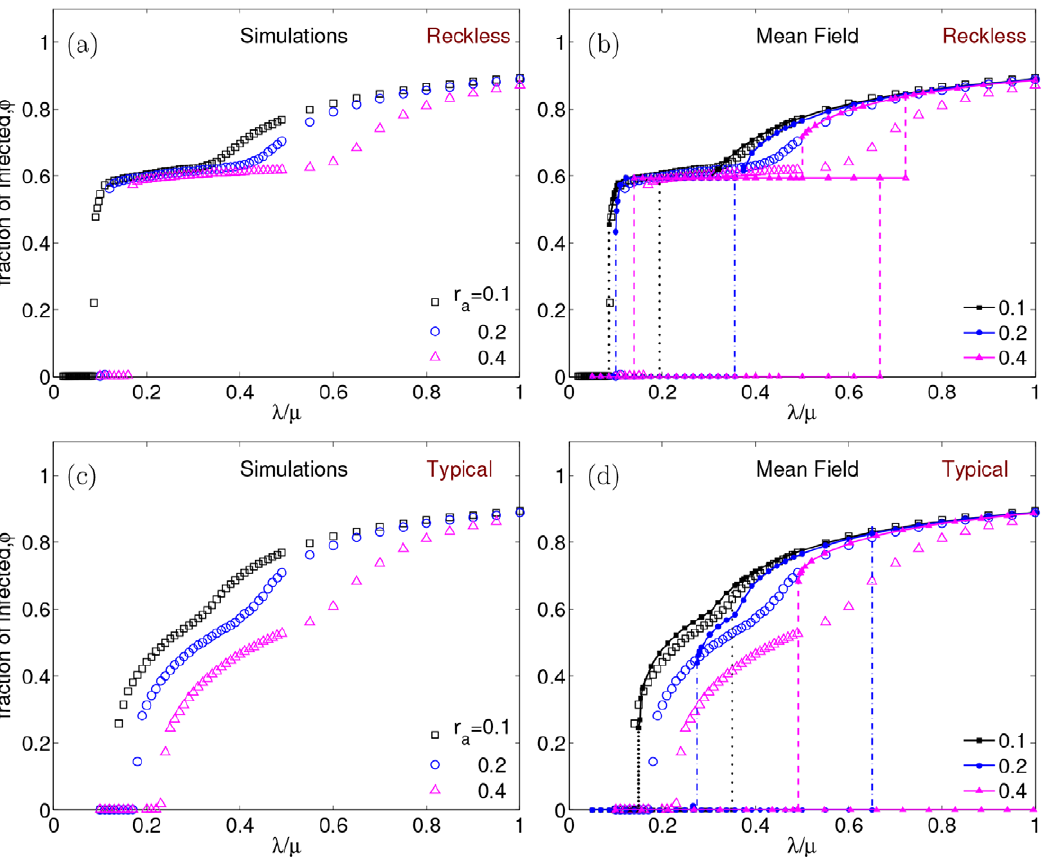
Figure 7. SIS phase diagram for selective adaptations. The fraction of infected population w , versus l = m for different network adaptation rates, with parameters N ~ 1000 , k 0 ~ 25 , k min ~ 10 , c = k 0 ~ 10 . Panels (a) and (c) show the Monte-Carlo simulation results for reckless and typical behaviors (see Sec. II.a) respectively. In panels (b) and (d), the simulation results are compared to local mean field theory (described in Appendix S1) predictions. The black squares, blue circles and magenta triangles represents the network adaptation rates r a ~ 0 : 1,0 : 2 and 0 : 4 respectively. The corresponding mean fields results are plotted as lines with respective colors in (b) and (d). The dotted, dot-dash and dashed lines represent the bistable regions obtained from mean field solutions when initial infection fraction is varied from w 0 ~ 0 : 05 to 0 : 8 and initial links chosen from following the hysteresis curve.